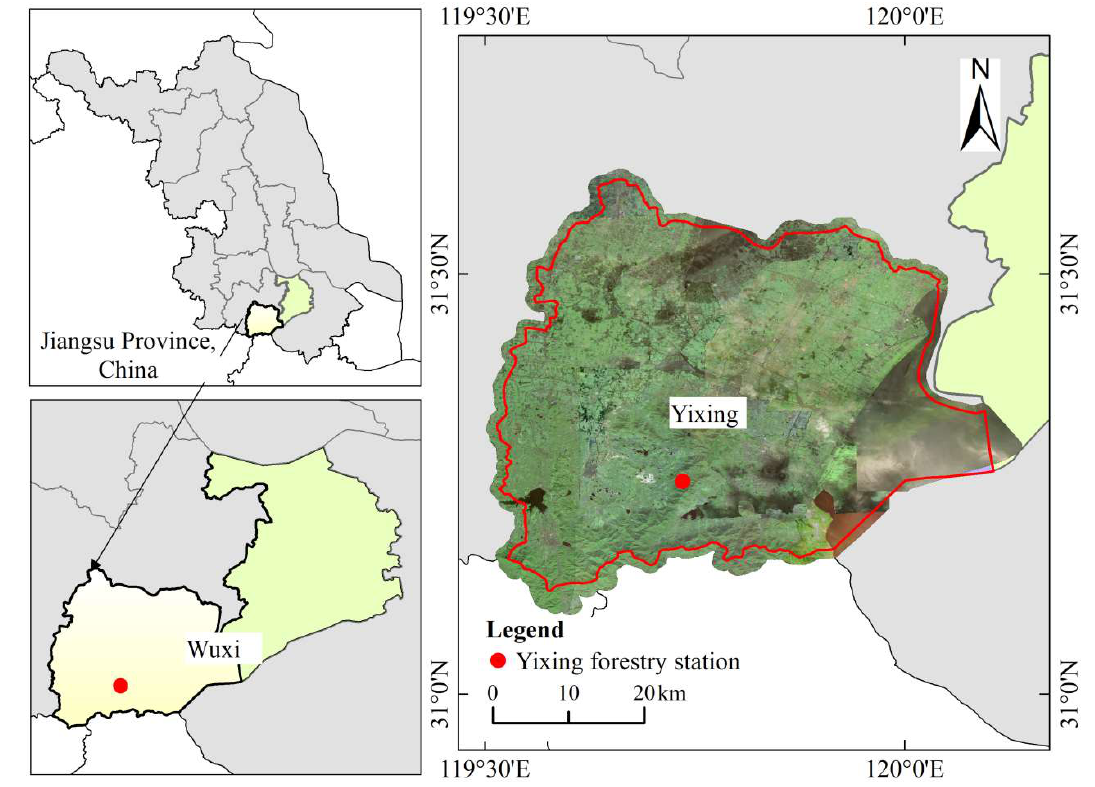
Figure 1. Location of the study area.